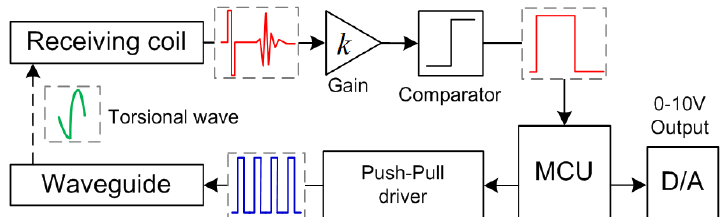
Figure 6. Block diagram of the circuit